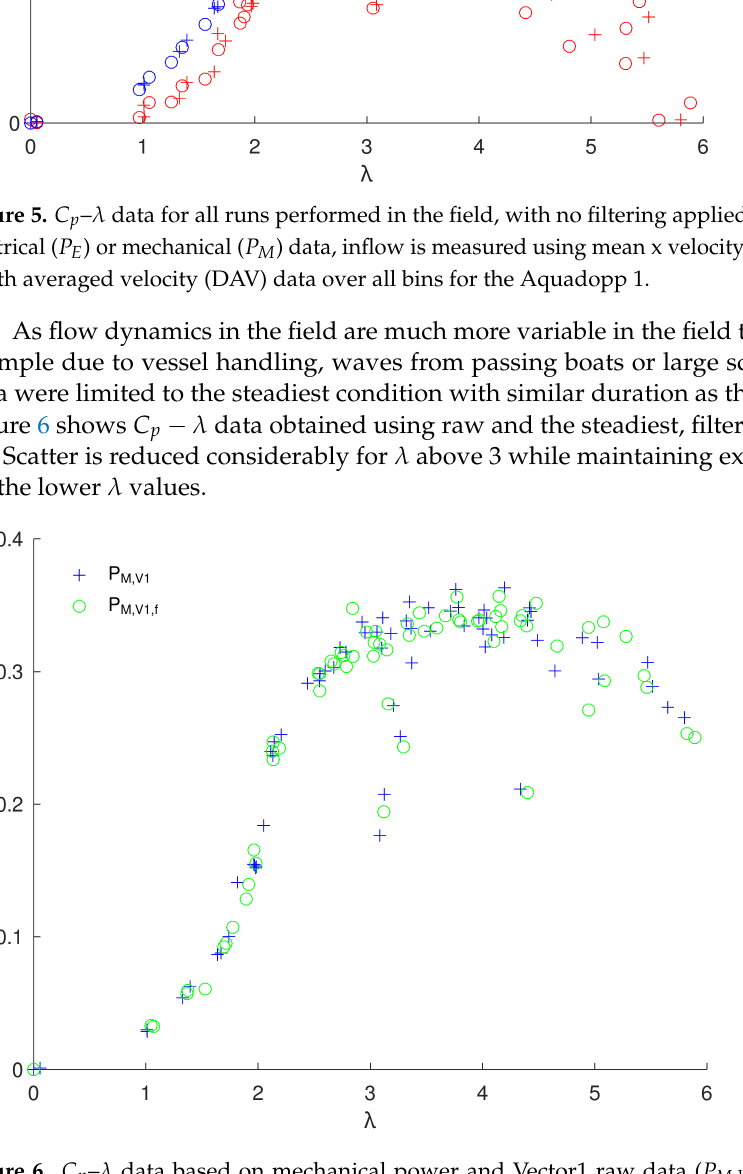
Figure 6. C p – λ data based on mechanical power and Vector1 raw data ( P M . V 1 ) vs steadiest 30 s sample ( P M . V 1, f